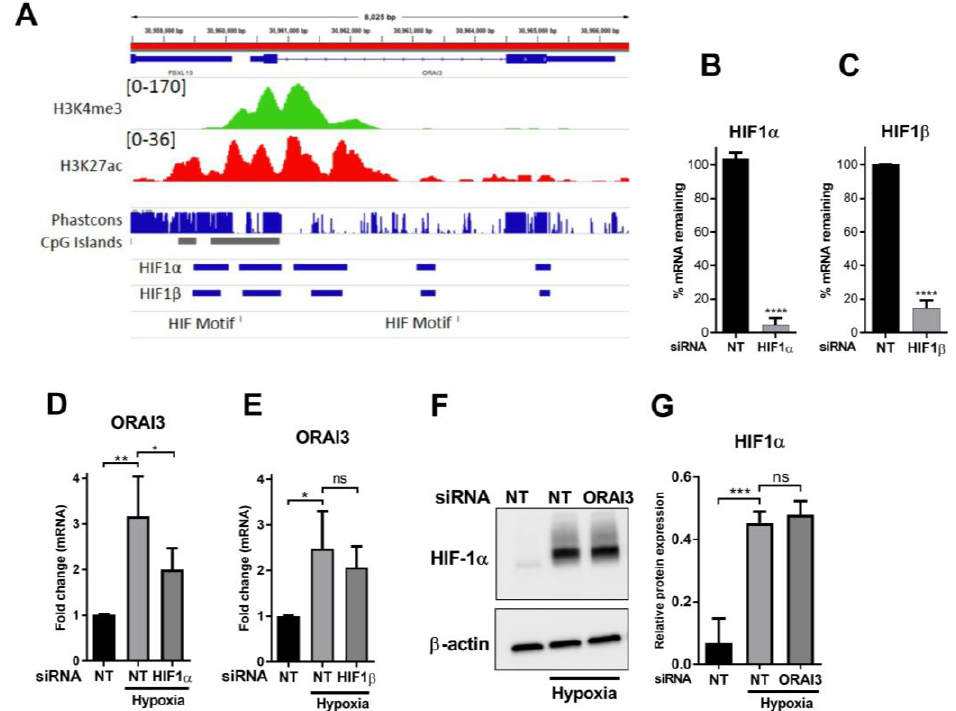
Figure 3. Hypoxia-induced Orai3 up-regulation is HIF1 α dependent. ( A ) The ORAI3 genomic region on human chromosome 16. Displayed are the histone modifications (human m epithelial cells, HMEC) indicative of active promoters, conservation (Phastcons), CpG islands, HIF1 binding (MCF7 cells)